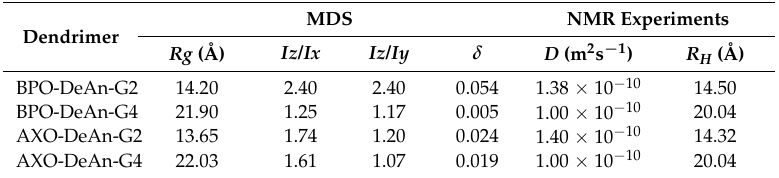
Table 1. Radius of gyration Rg , aspect ratios ( Iz / Ix and Iz / Iy ), asphericities ( δ ) [calculated by MDS]